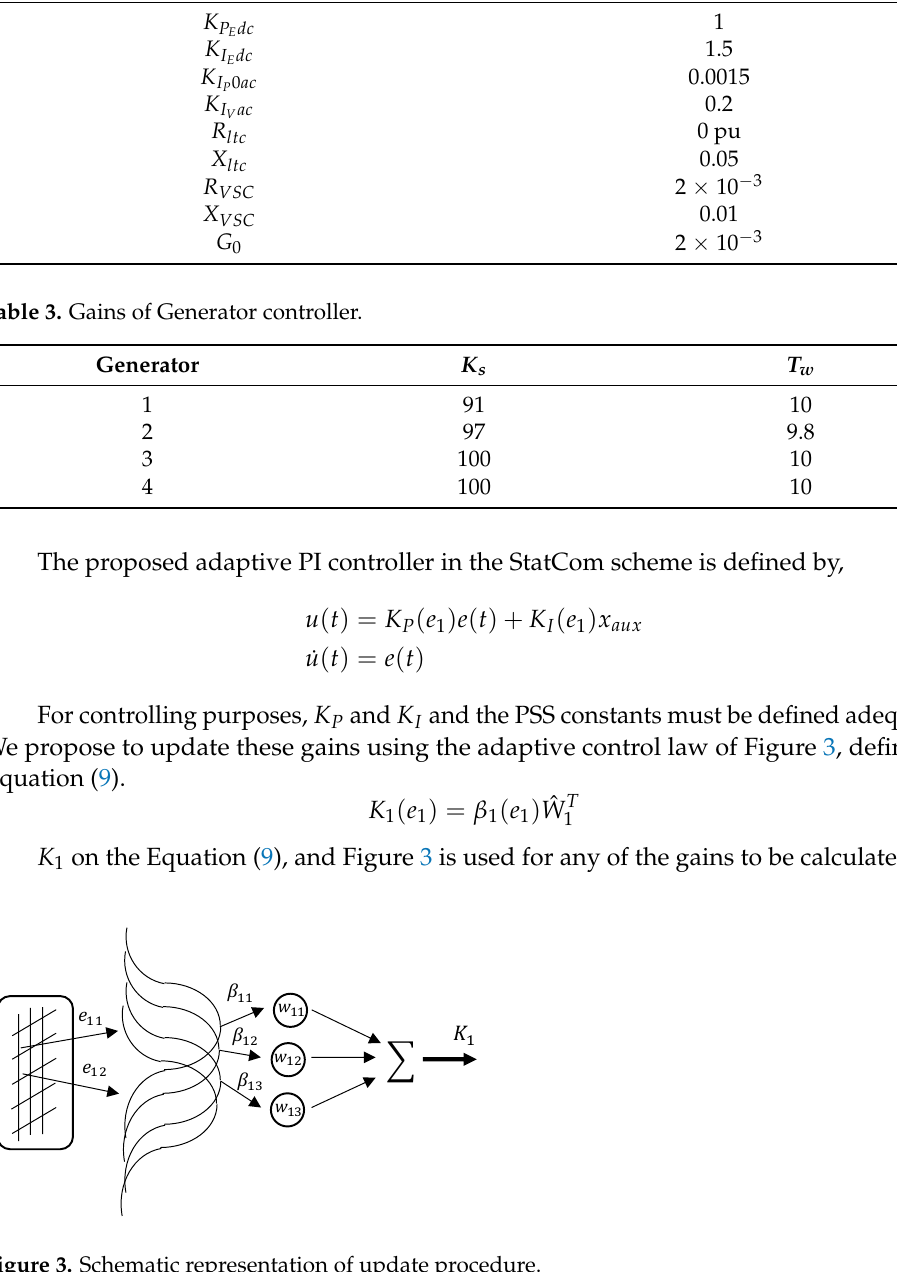
Figure 3. Schematic representation of update